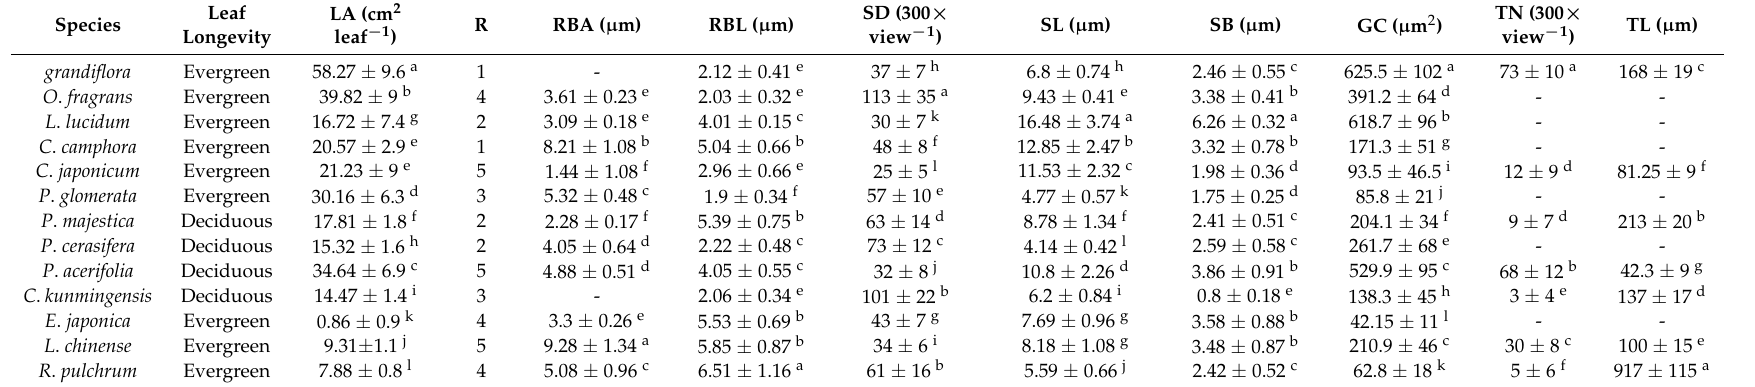
Table 3. Leaf surface traits of 13 trees and shrub species in Kunming City,